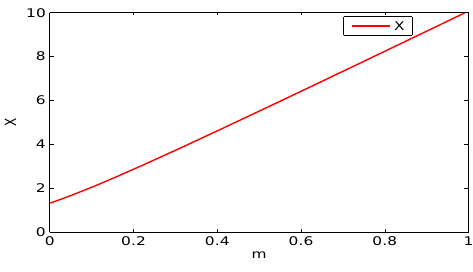
Figure 10: Bifurcation diagram of the prey species of model (1.4), m as the bifurcation